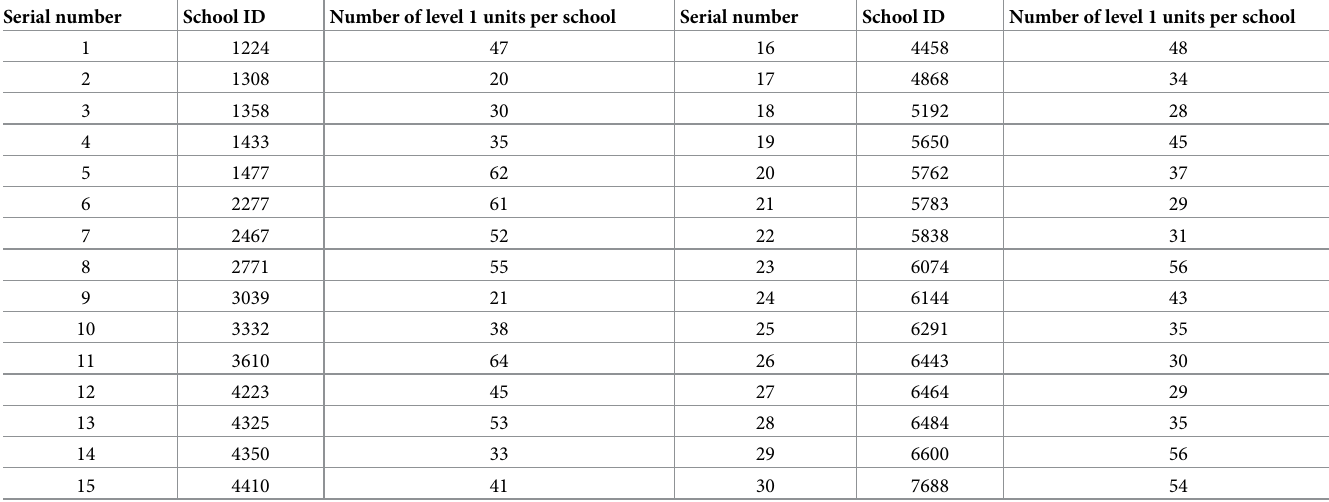
Table 10. High school & beyond data (30 schools data set).